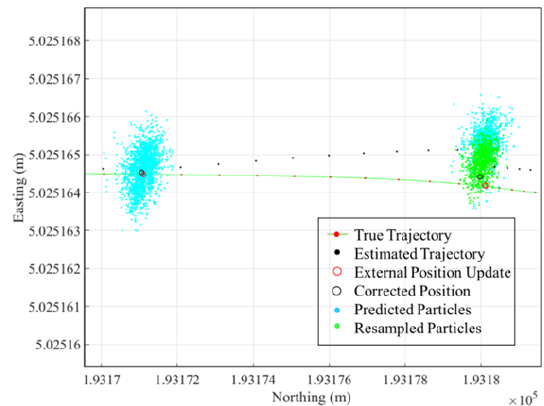
Figure 9. Positional errors of three different trajectories; a) camera-aided UPF; b) GNSS aided UPF; c) IMU